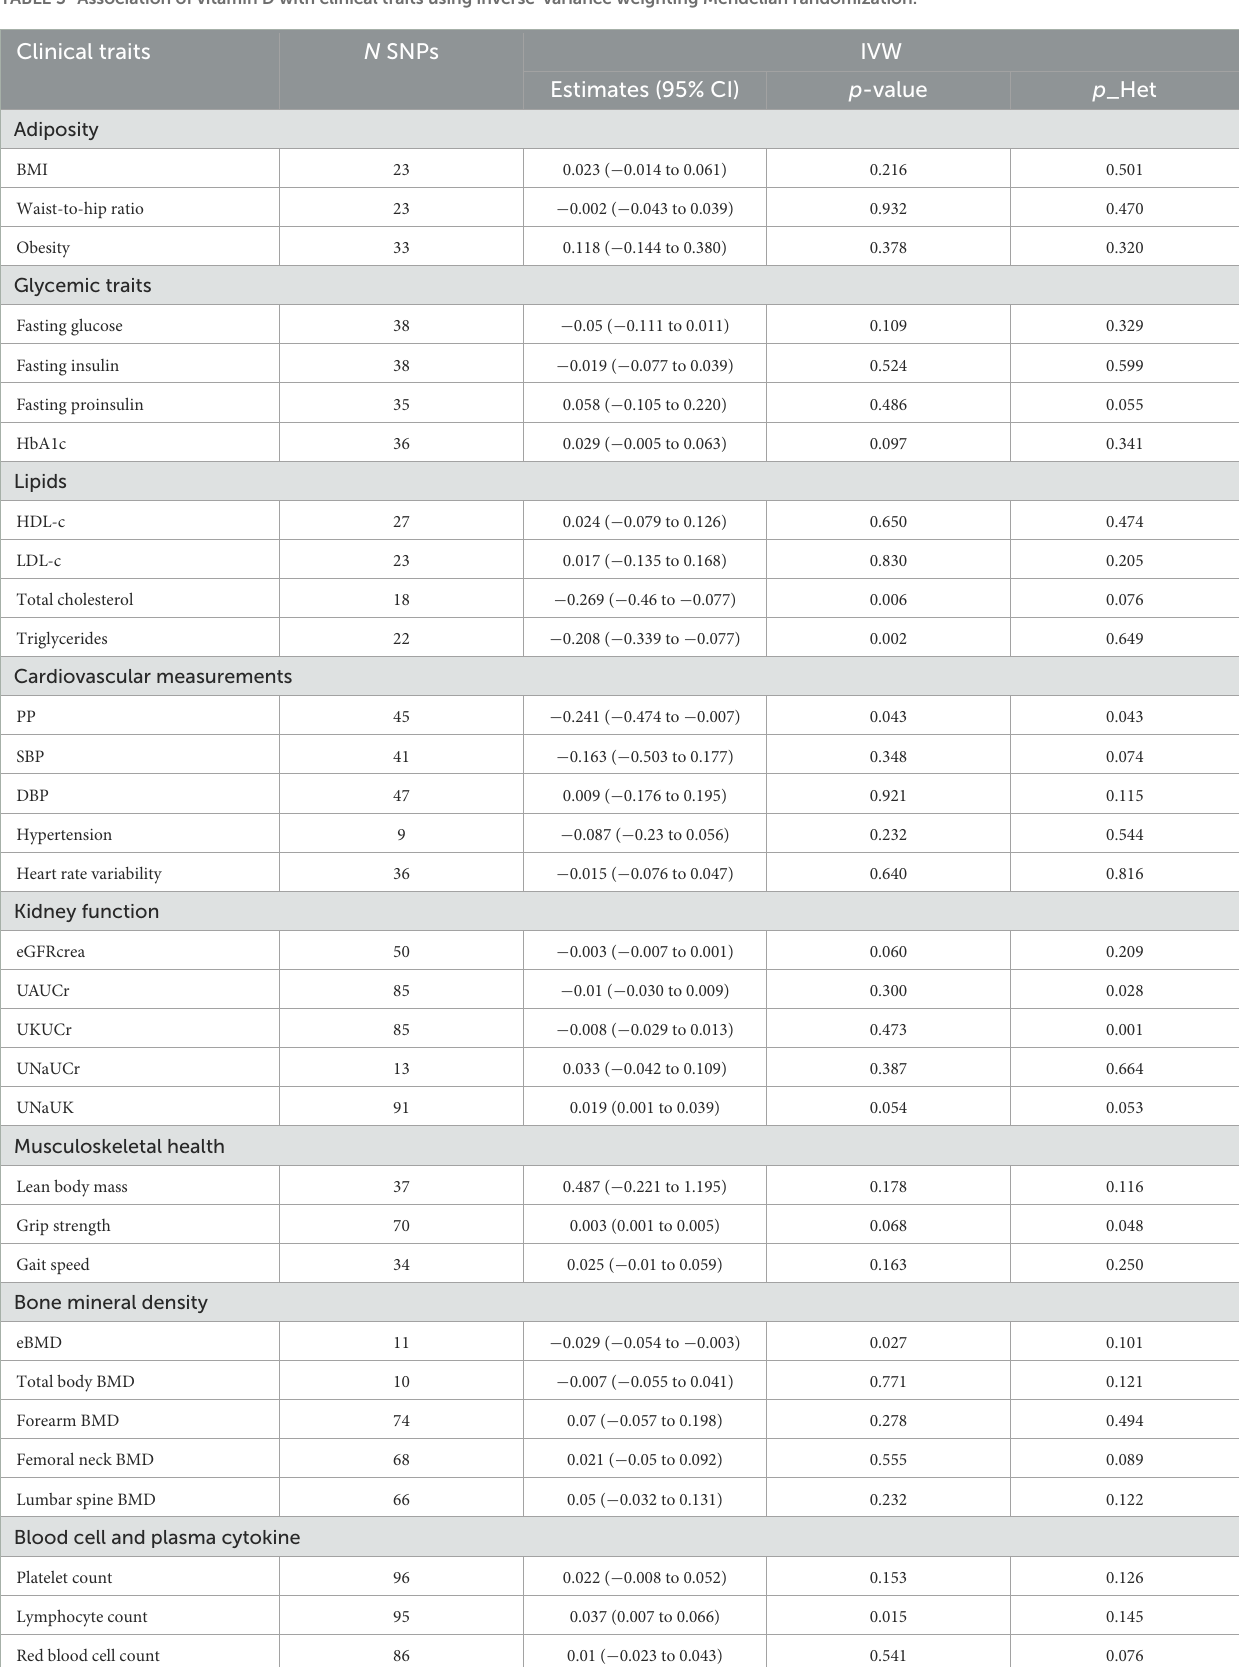
TABLE 3 Association of vitamin D with clinical traits using inverse-variance weighting Mendelian randomization. Clinical